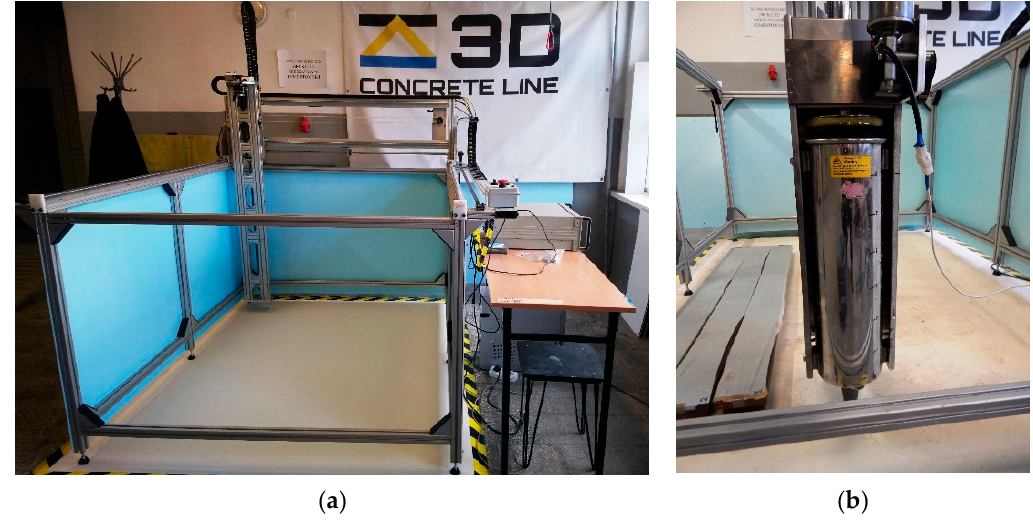
Figure 1. 3D concrete printer: ( a ) work space; ( b ) extruder module.